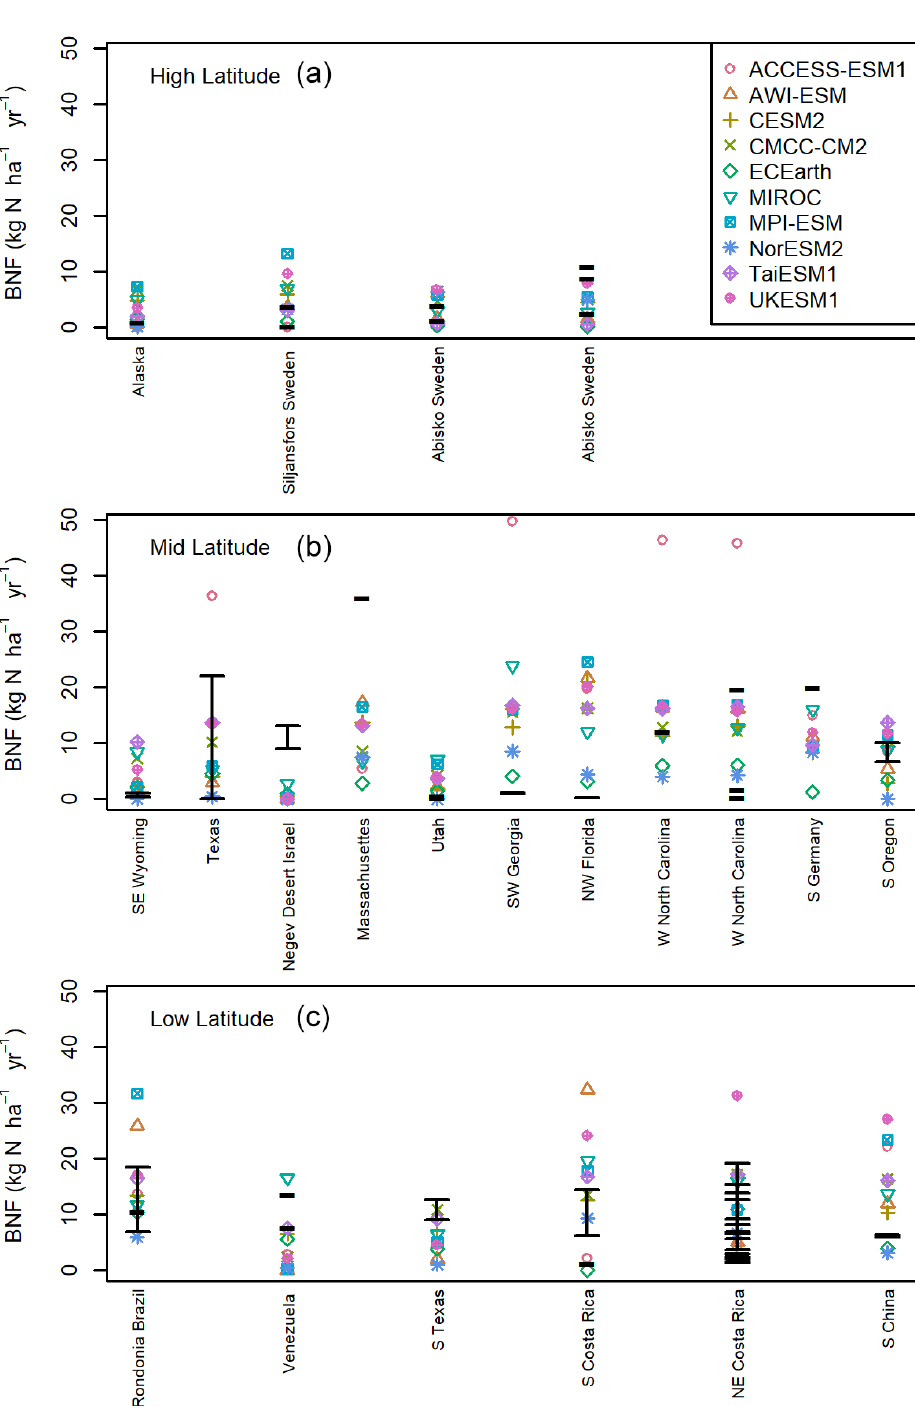
Figure 3. BNF field-scale observations in kgNha − 1 yr − 1 plotted over the model BNF value for the nearest grid cell, matched to the latitude and longitude. (a) More than 60 ◦ N or 60 ◦ S. (b) Less than 60 ◦ N and more than 30 ◦ N, less than 60 ◦ S and more than 30 ◦ S. (c) Observations less than 30 ◦ N and less than 30 ◦ S. The black lines represent single values or the confidence range as reported by the paper the observational data come from (see Table